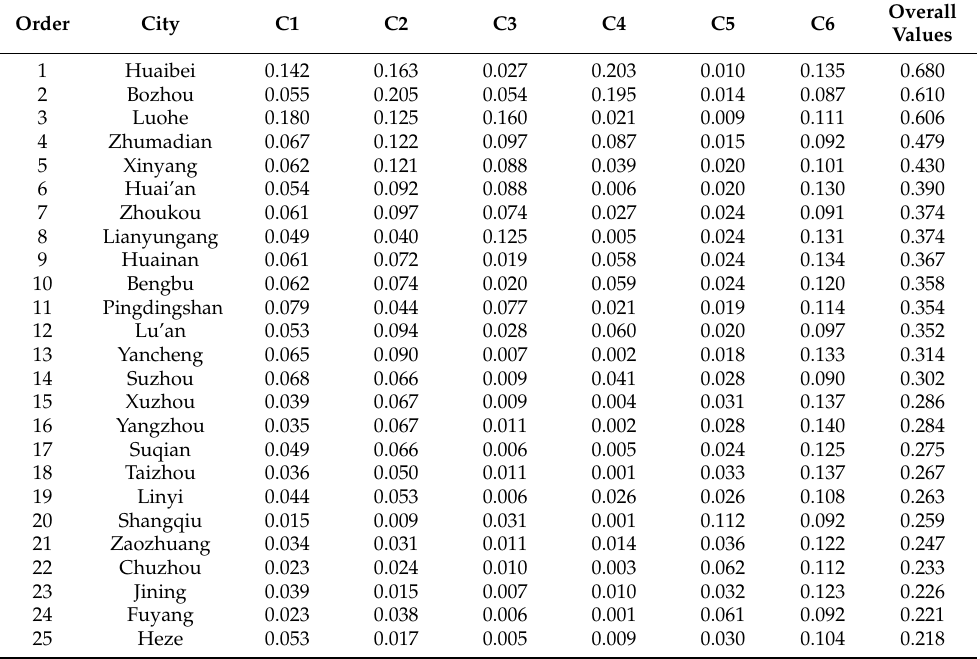
Table A3. Evaluation index value and grade of resource and environment carrying capacity (index